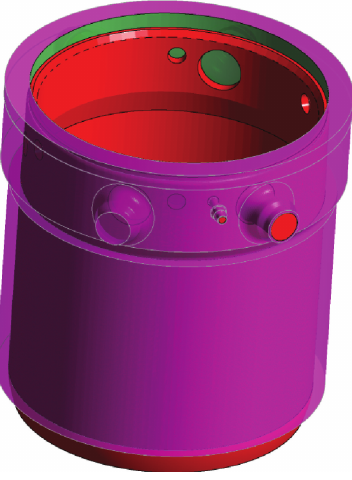
Figure 7: CFX model overall assembly.